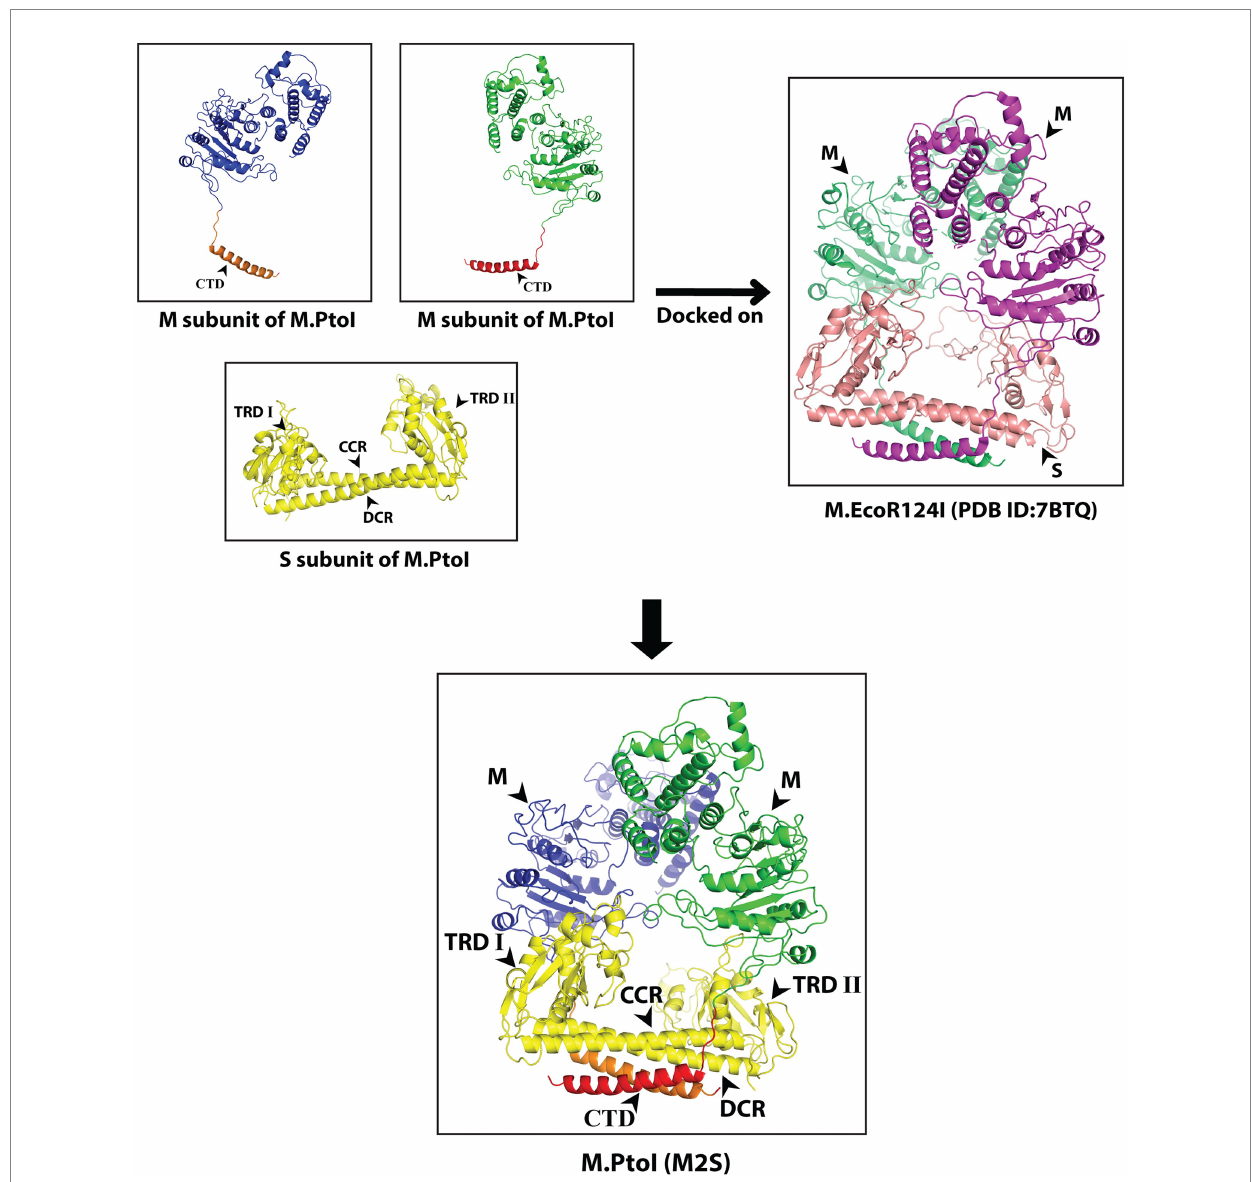
FIGURE 5 Predicted structure of M.PtoI: Predicted 3D structures of M and S subunits of M.PtoI were superimposed on the 7BTQ M.EcoR124I holoenzyme structure. M.PtoI structure was thus obtained using template-based docking. M: M subunit, CTD: C-terminal domain, TRDI and TRDII: Target Recognition Domain I and II respectively, CCR: Central Conserved Region, DCR: Distal Conserved